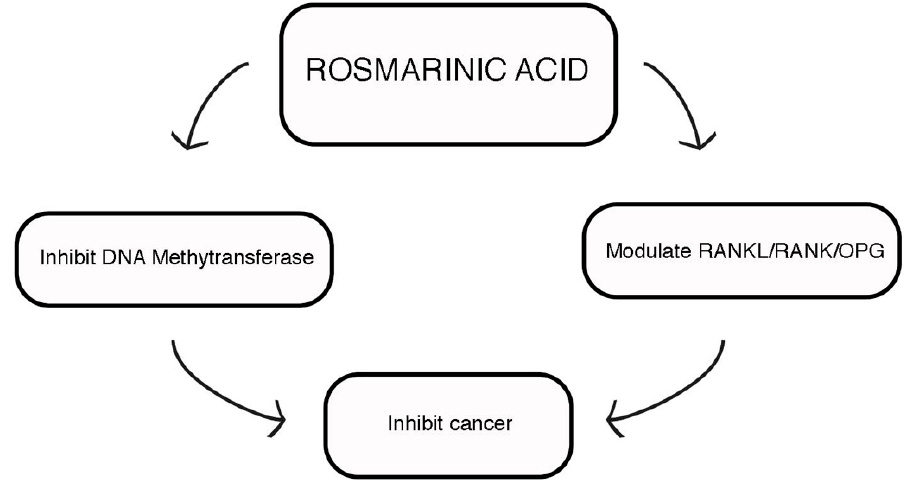
Figure 3. Mechanism of rosmarinic acid as an anticancer agent.